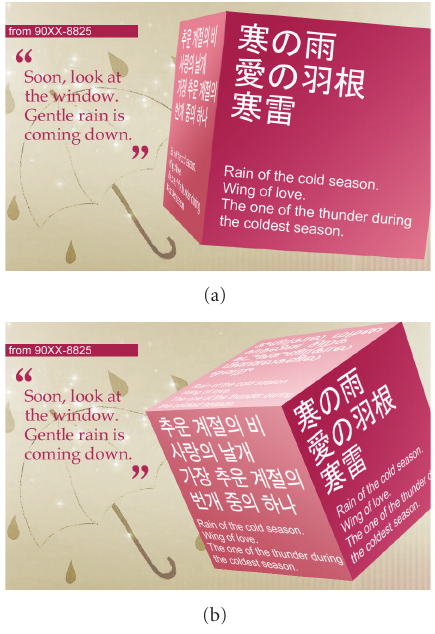
Figure 4: BlogWall poetry.